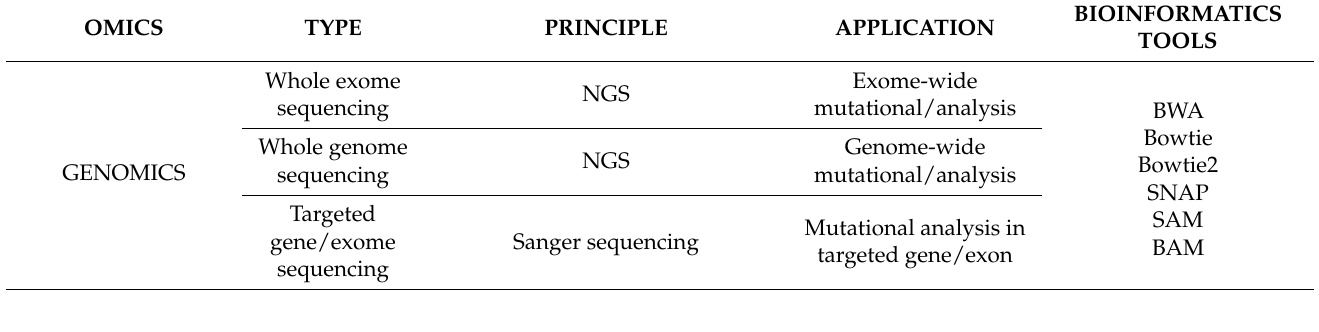
Table 1. Summary of the applications of different techniques for sequencing, which are at the basis of different omics data acquisition approaches. Genomics, epigenomics, and transcriptomics are based on NGS techniques, whereas proteomics and metabolomics are driven by mass-spectrometric (LC-MS/MS) method. The main goal of genomics, epigenomics, and transcriptomics is the screening of genome-wide mutations, the identification of altered epigenomic modifications, and exploring differential RNA expression, while for proteomics and metabolomics is the identification of differentially regulated proteins and metabolites (reprinted from reference